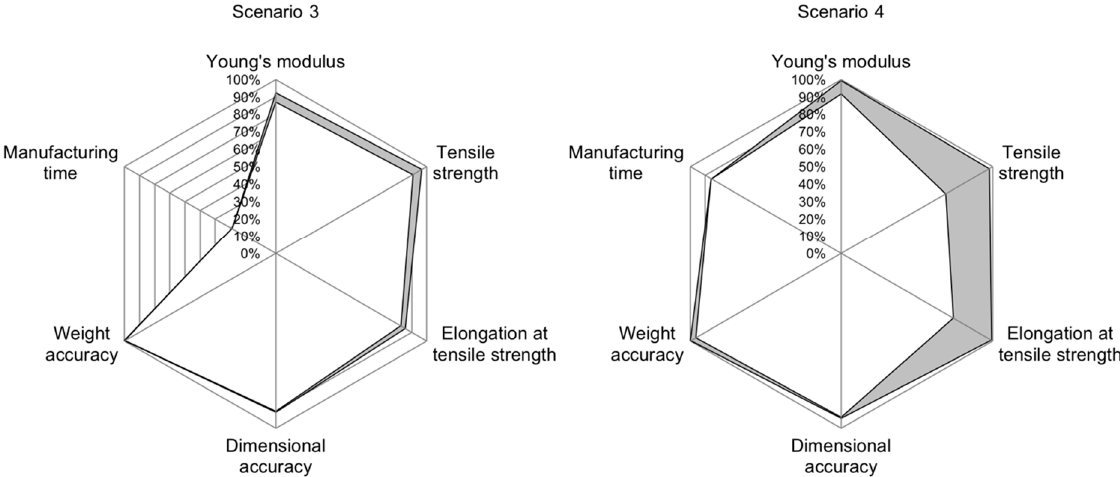
Figure 8. Radar chart for input accuracies in scenario 3 ( left ) and 4 ( right ). The gray band shows the interval between best and worst accuracy for each quality characteristic.